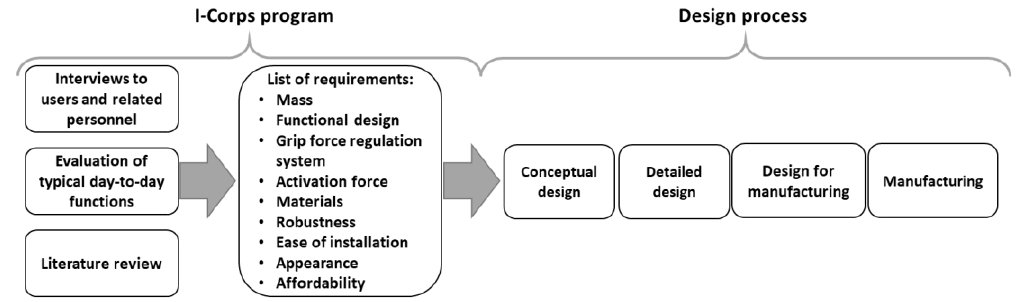
Figure 1. Methodology overview.